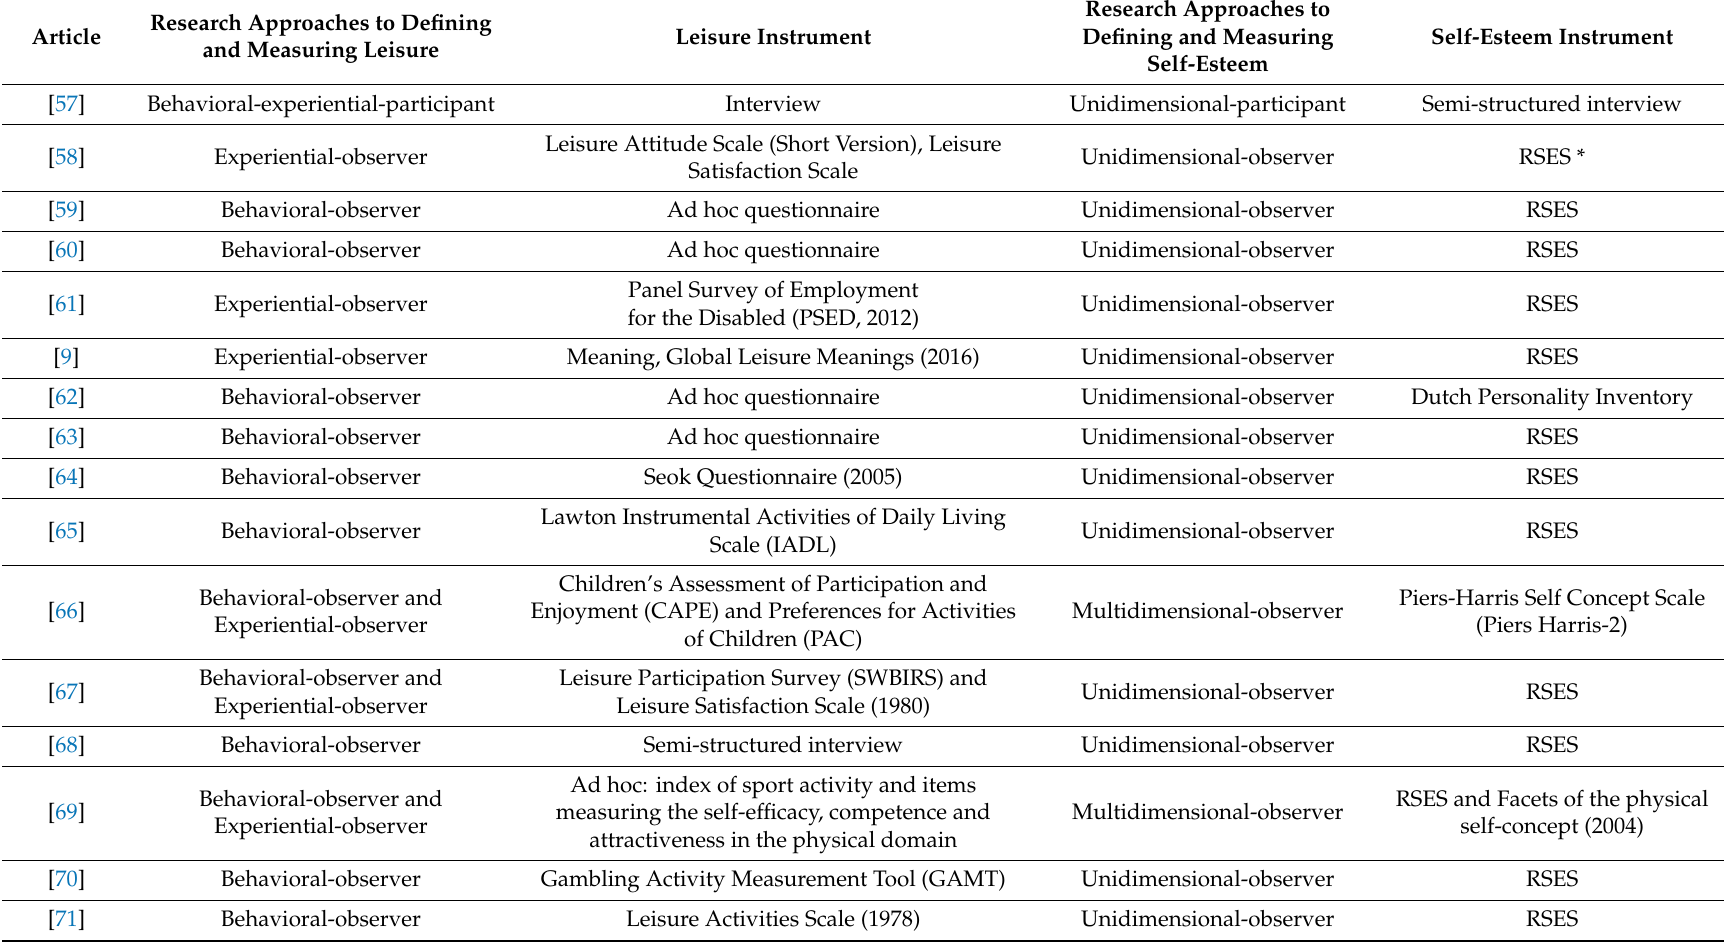
Table 3. Articles